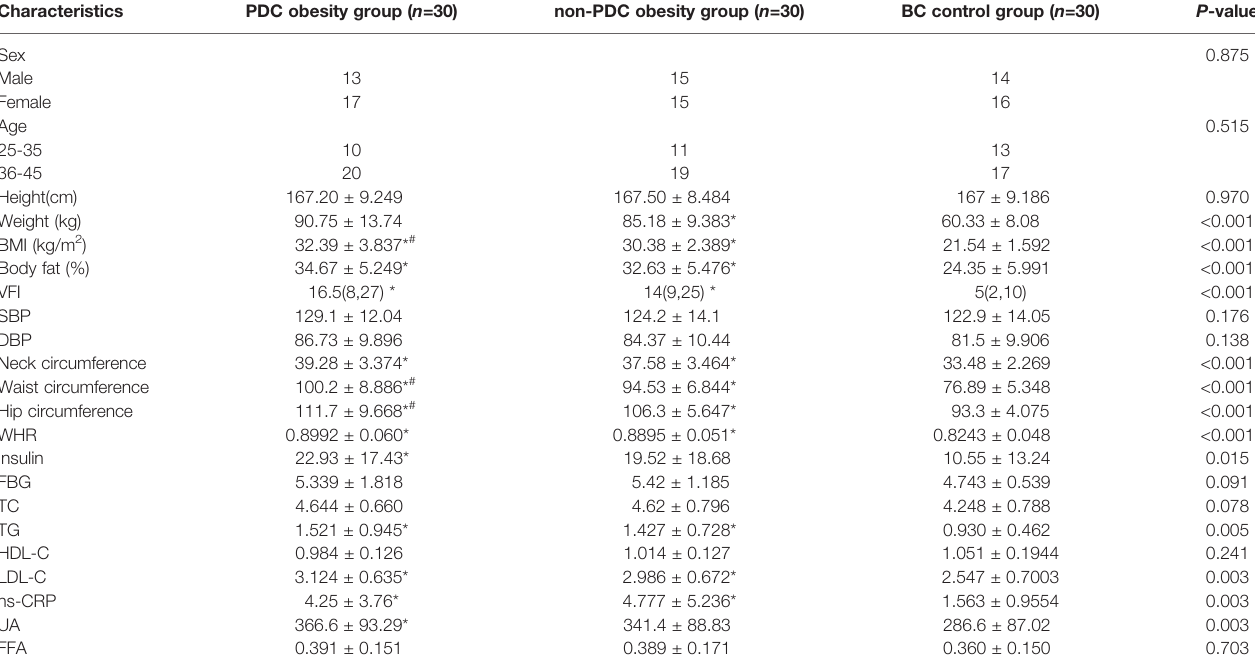
TABLE 1 | Characteristics of the study